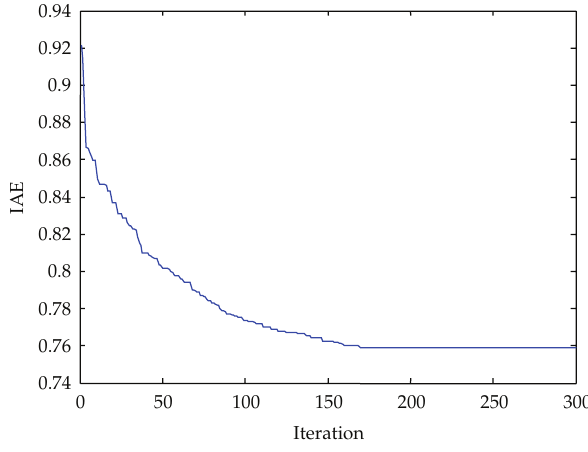
Figure 2: Convergence curve of